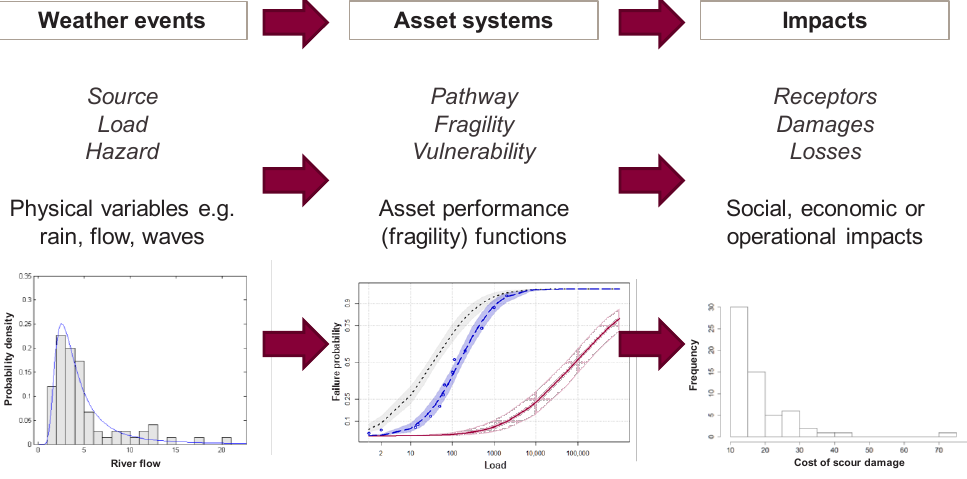
Figure 1. High-level conceptual risk